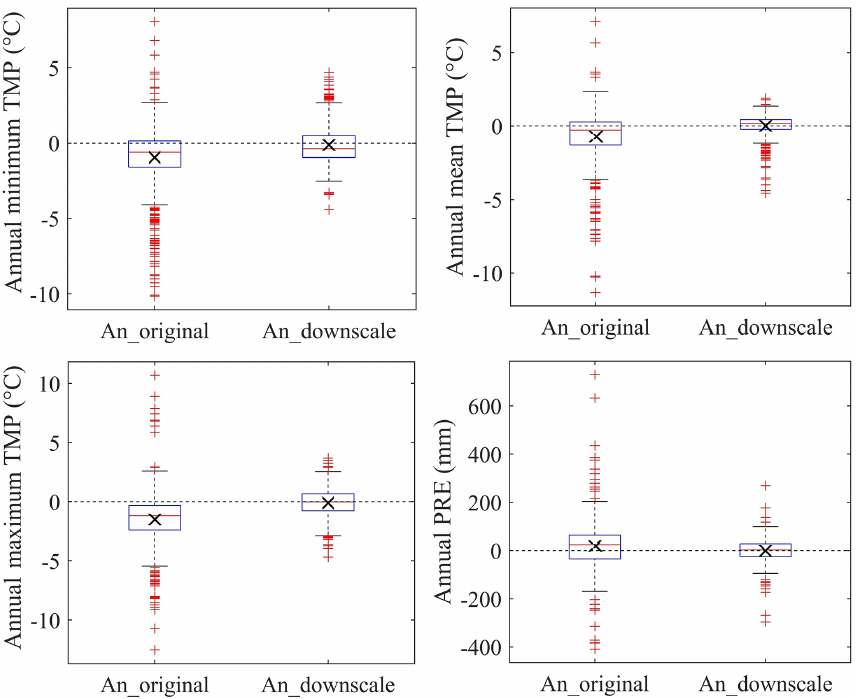
Figure 6. Box plots of climatology anomaly during 1951–2016 for 30 (cid:48) original and 0.5 (cid:48) downscaled datasets at independent weather stations. The climatology anomaly is equal to the bias from the original–downscaled to the observed values. Red lines in boxes show median values. Boxes indicate the inter-quantile range (25%–75%). Crosses ( × ) in boxes indicate the averages of all anomaly values. Horizontal dotted lines indicate zero values. An_original and An_downscale indicate climatology anomalies of the 30 (cid:48) original and 0.5 (cid:48) downscaled datasets, respectively. The 0.5 (cid:48) downscaled datasets were generated using bilinear interpolation in the delta downscaling framework.